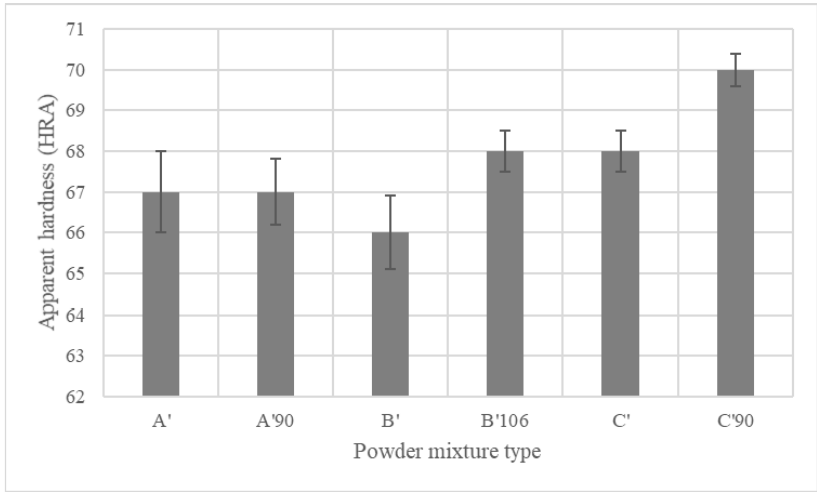
Figure 18. Apparent hardness for core region of standard TRS samples prepared from various PMS mixtures (including 0.7 wt. % of a lubricant).